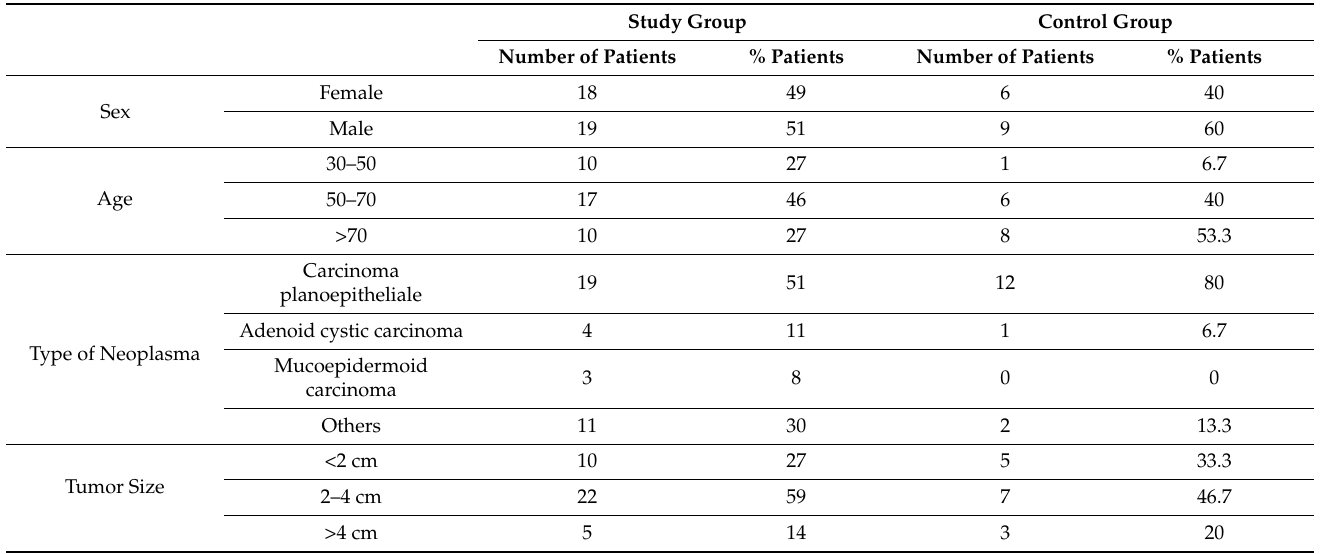
Table 1. Structure of